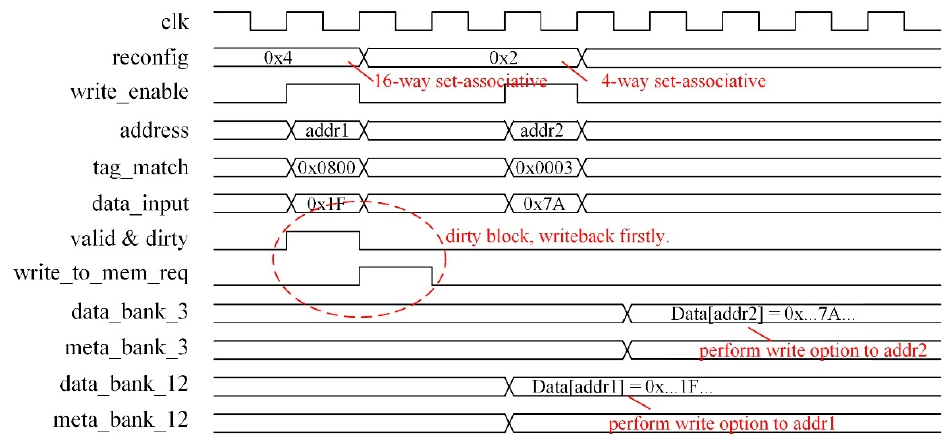
Figure 15. Waveform of cache write